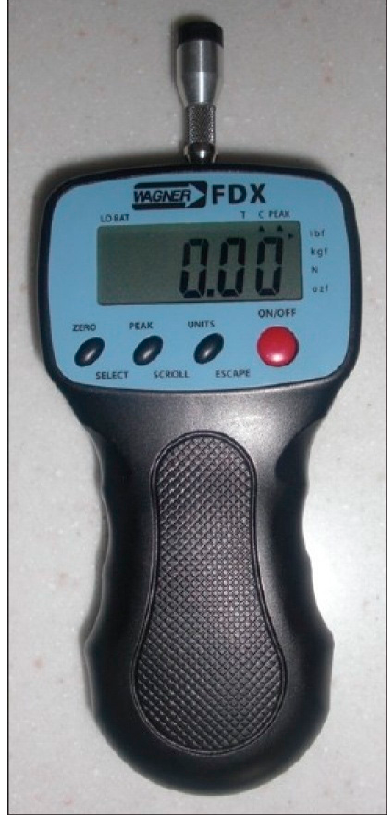
Figure 1. Wagner Paintest FPX 25.